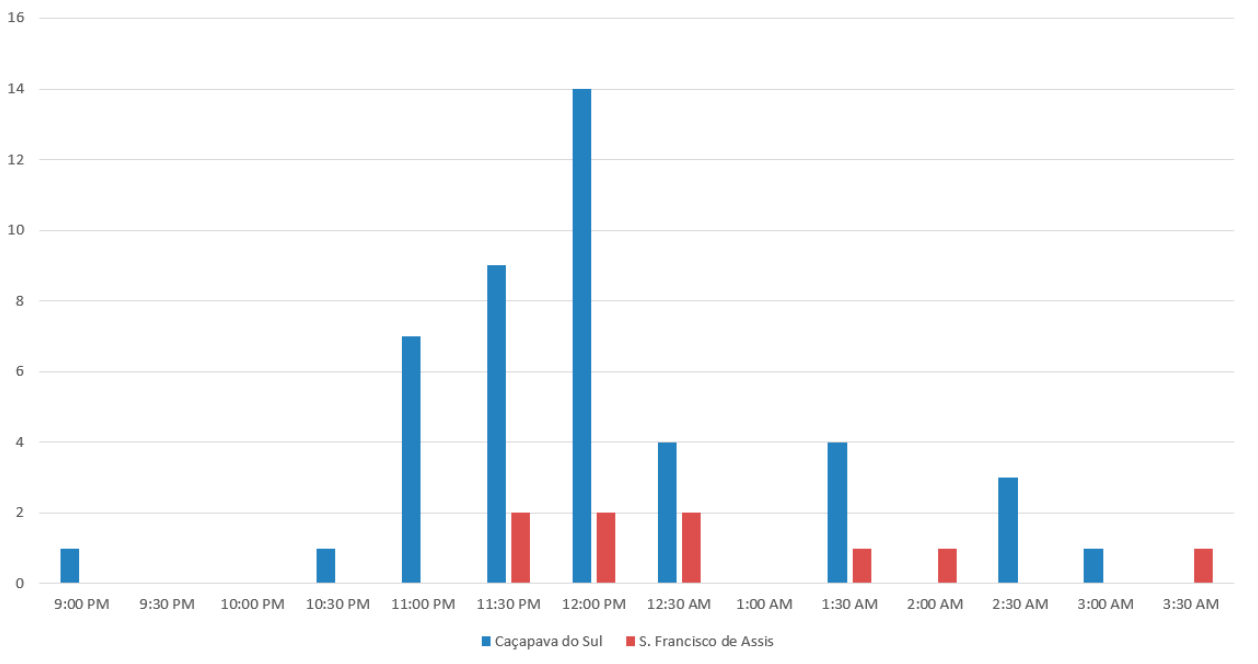
Figure 3. Number of hawk moths interactions in half-hour intervals during anthesis of Cereus hildmannianus in two different localities: Caçapava do Sul (five nights) and São Francisco de Assis (four nights), Rio Grande do Sul State, Southern Brazil.